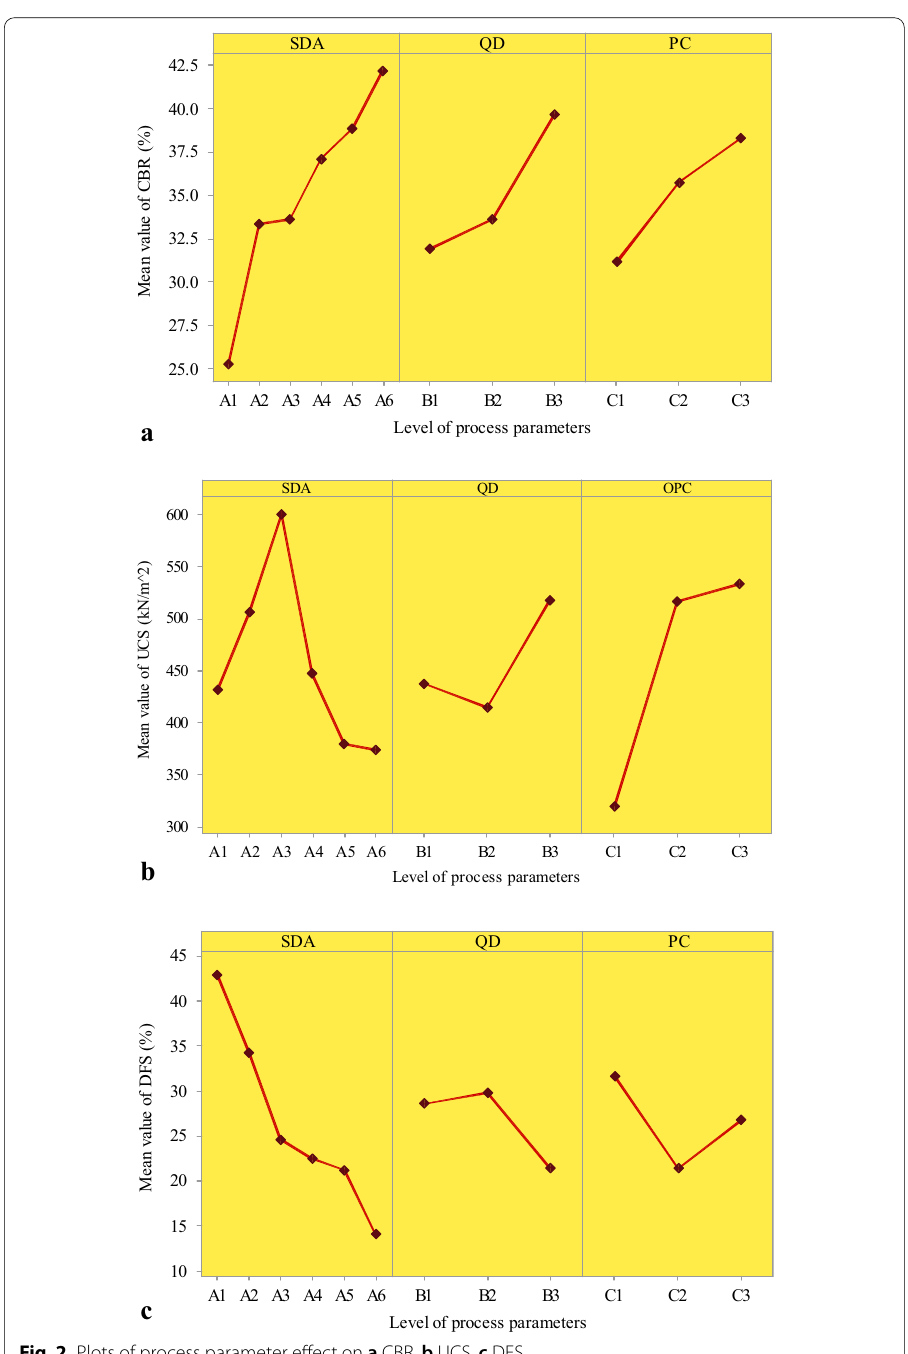
Fig. 2 Plots of process parameter effect on a CBR, b UCS, c